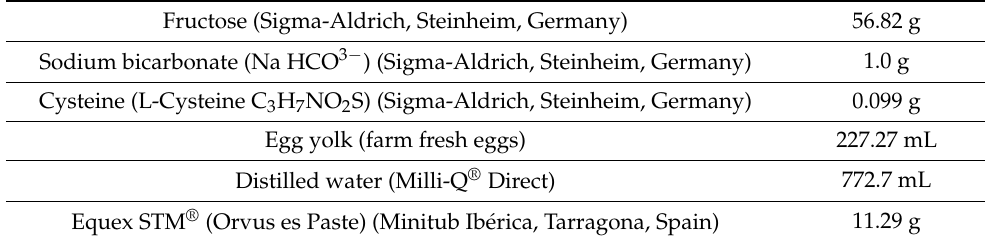
Table 1. Composition of the Thilmant (1997) sperm-freezing extender (fraction A) for a total volume of 1 L (distilled H 2 O + egg yolk).